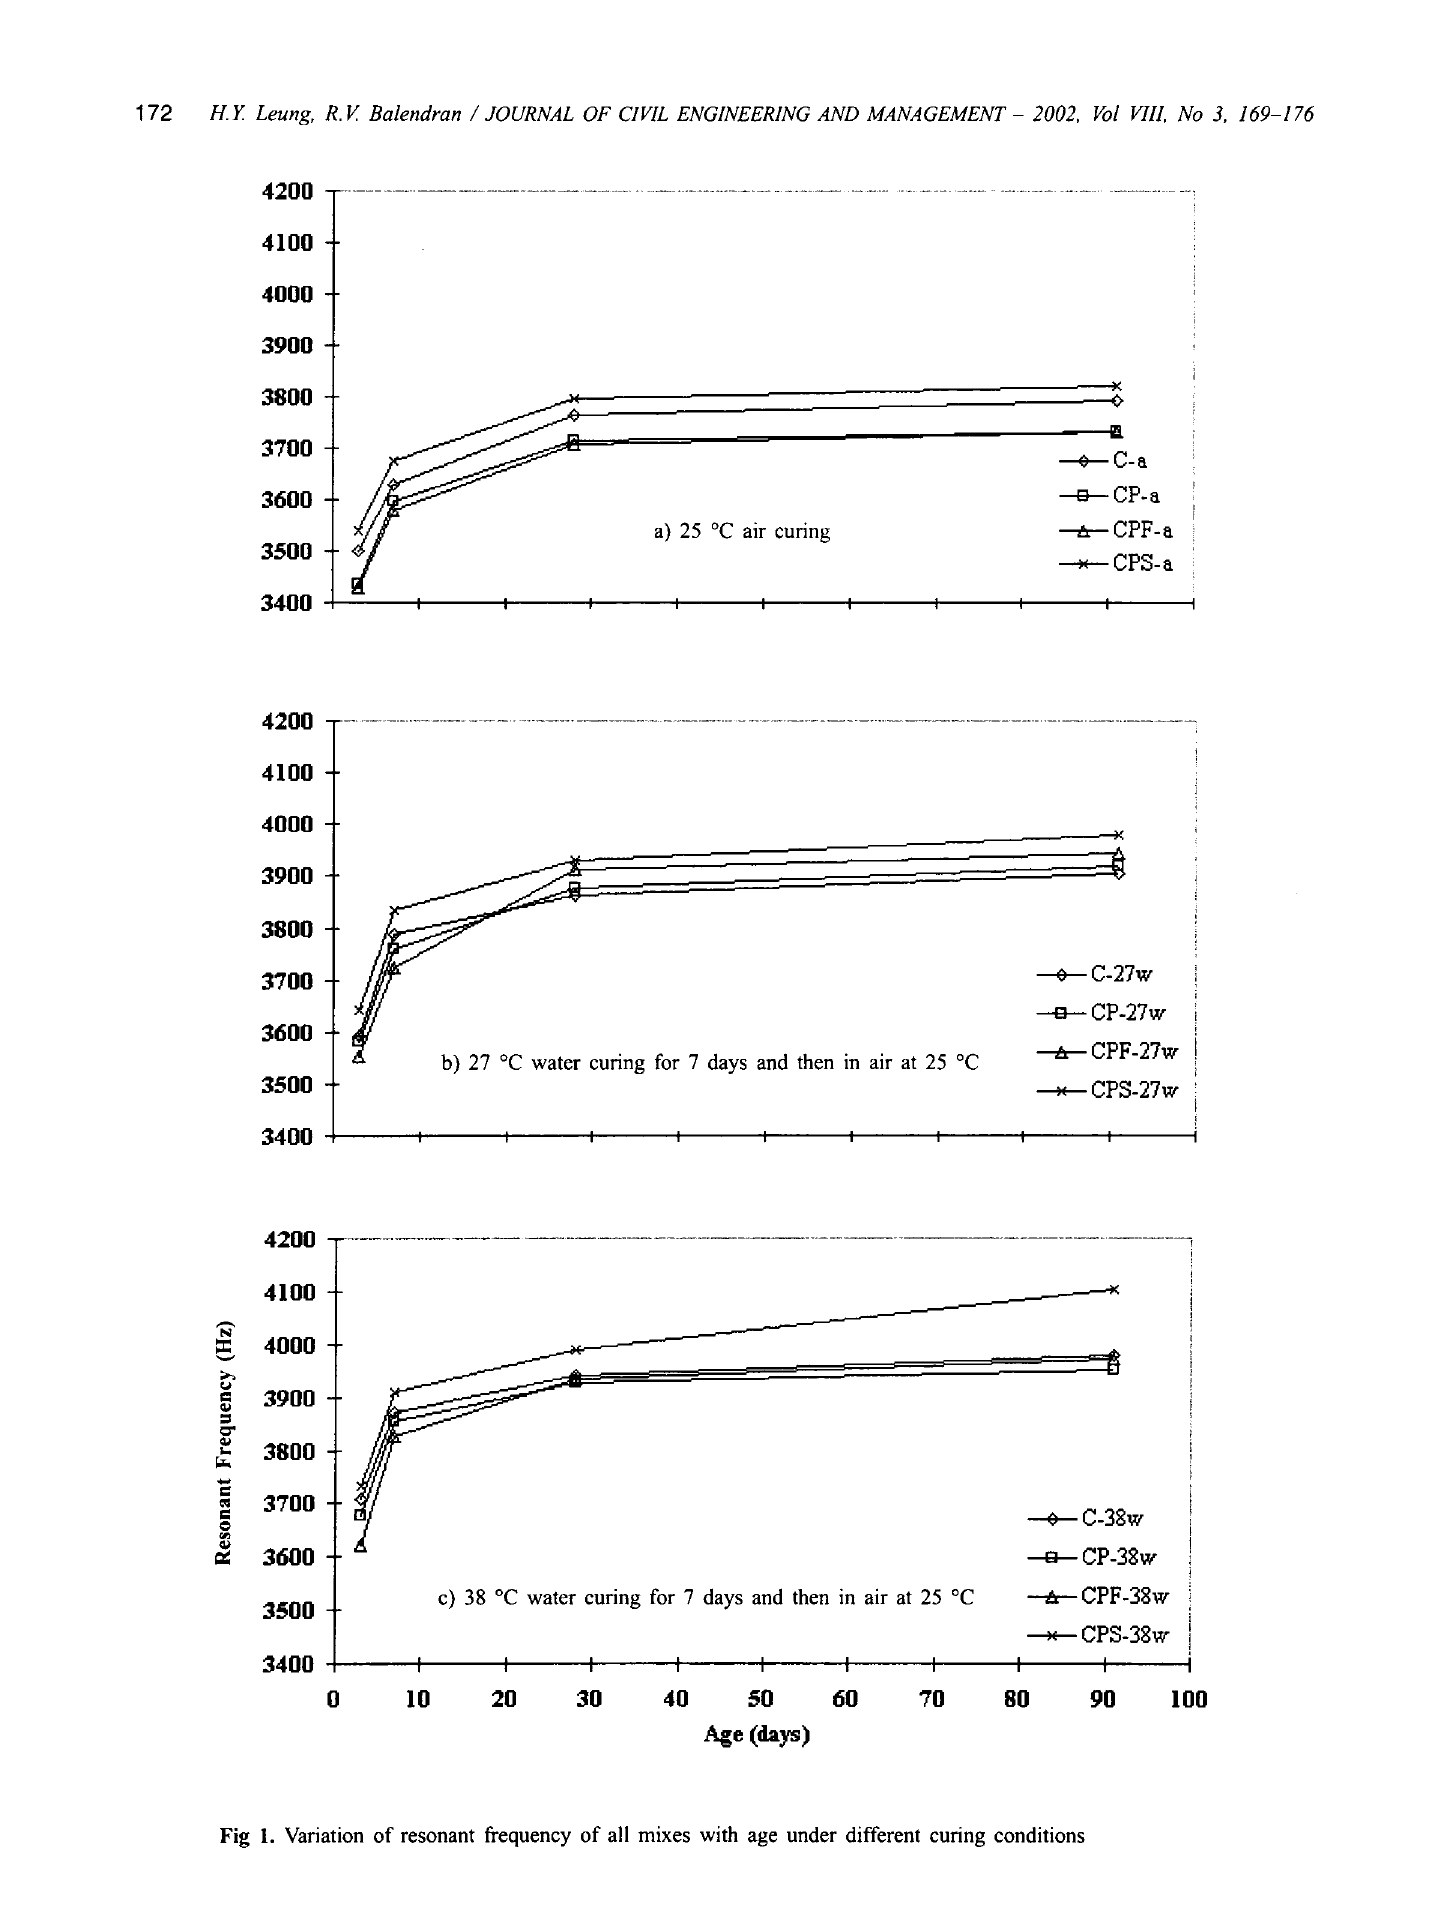
Fig 1. Variation of resonant frequency of all mixes with age under different curing